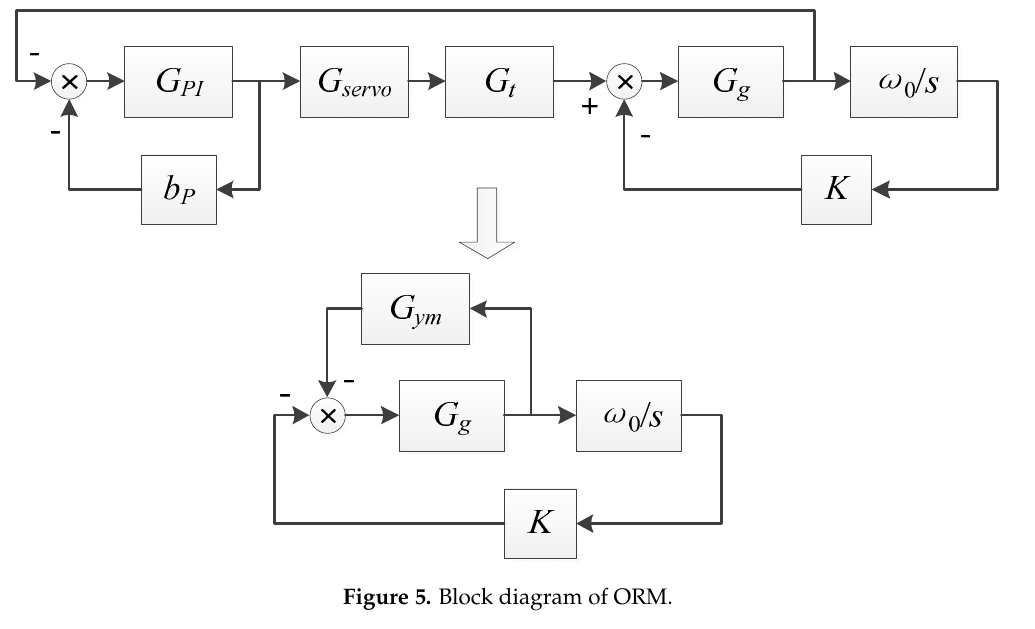
Figure 5. Block diagram of ORM.